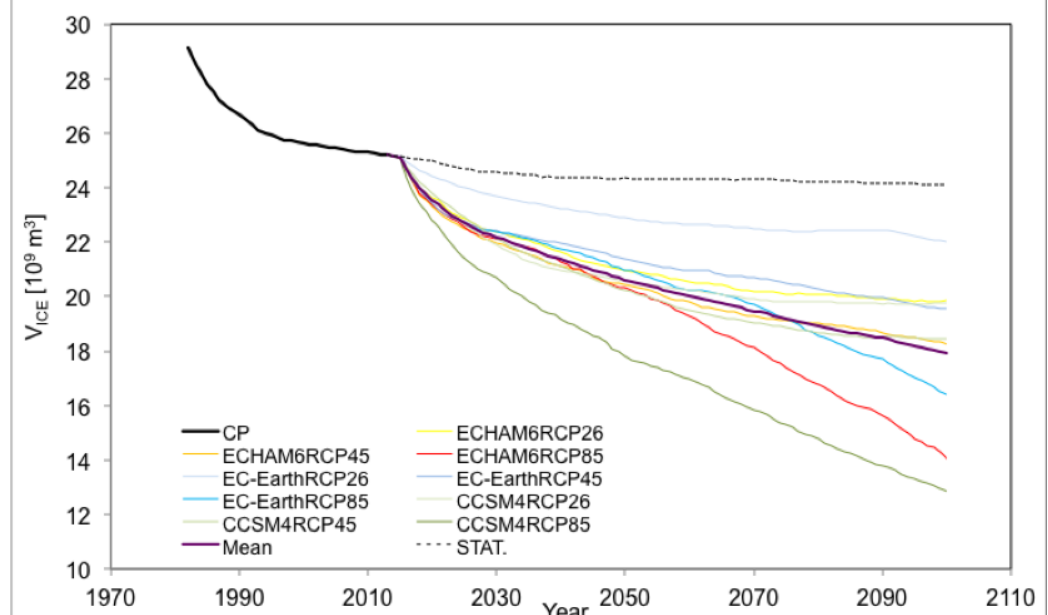
Figure 6. Projected ice volume until 2100 vs. simulated ice volume during CP. Also, projected ice volume is reported under stationary (STAT) climate conditions, for